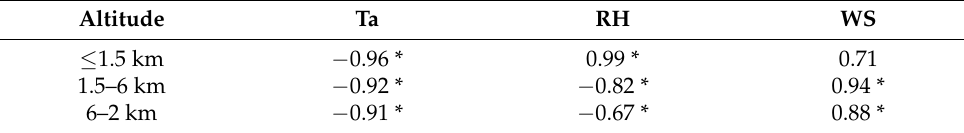
Table 2. Correlation coefficients between wintertime tropospheric OVMR and various meteorological factors, including air temperature (Ta), relative humidity (RH), and wind speed (WS) measured at the Shaowu station.